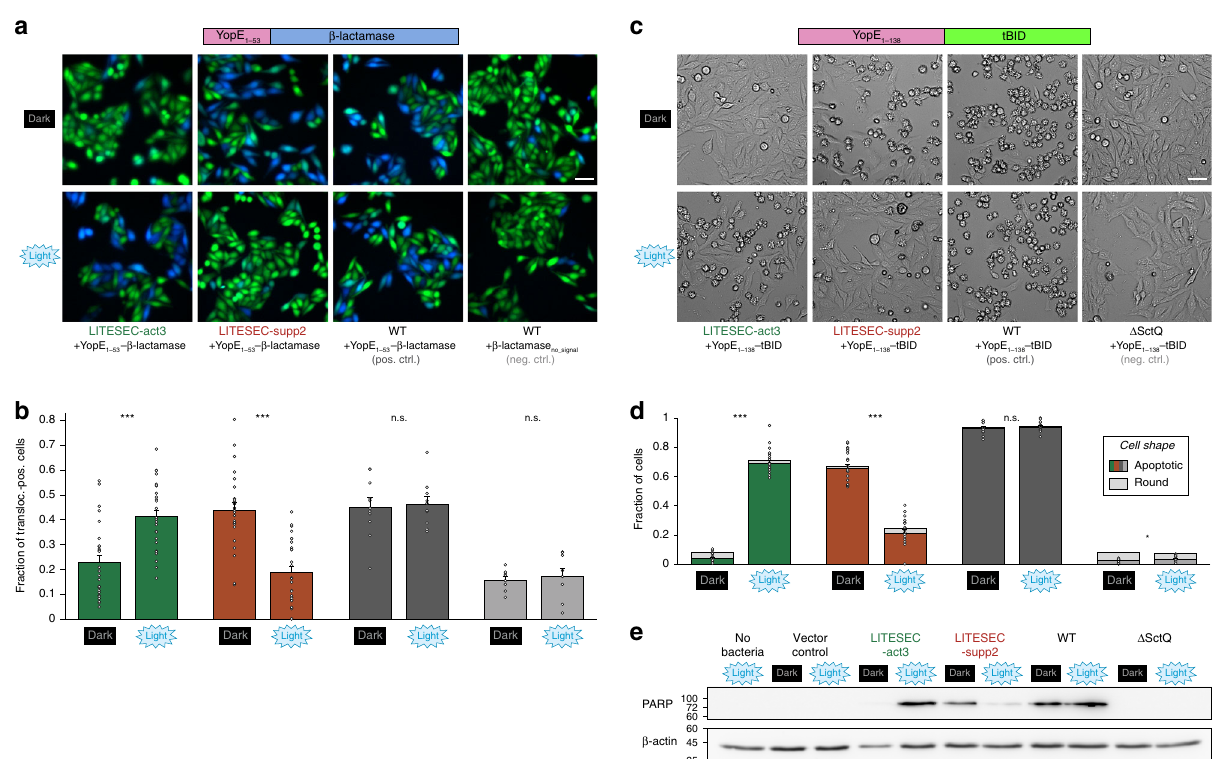
Fig. 8 Light-dependent translocation of heterologous cargo into eukaryotic host cells. a Fluorescence micrographs depicting cultured HEp-2 cells that were incubated with the indicated strains expressing either a heterologous T3SS substrate, YopE 1-53 - β -lactamase, or β -lactamase without a secretion signal as a negative control, for 60 min. Translocation of β -lactamase is detected by cleavage of the intracellular β -lactamase substrate CCF2 (leading to loss of FRET, and a transition from green to blue fl uorescence emission). Scale bar, 50 μ m. b Fraction of β -lactamase-positive HEp-2 cells in ( a ) (blue fl uorescence). 2343/2423/2226/2694 cells from 26/28/25/27 fi elds of view from three independent experiments were analyzed for the LITESEC strains under the given conditions from left to right (809/671/995/823 cells from 8/8/10/9 fi elds of view from three independent experiments for the controls). Single data points (percentage of positive cells per fi eld of view) indicated by circles; error bars display the standard error of the mean. *** p < 0.001 in a two-tailed homoscedastic t test; n.s., difference not statistically signi fi cant (exact values from left to right, 6 × 10 − 6 /2 × 10 − 8 /0.80/0.65). c Micrographs depicting cultured HEp-2 cells that have been incubated with the indicated strains expressing a heterologous T3SS substrate, YopE 1-138 -tBID 15 for 60 min. Translocation of tBID induces apoptosis, which leads to a condensed star-shaped host cell morphology. Scale bar, 50 μ m. d Visual classi fi cation of HEp-2 cells used in ( c ) after infection. 1522/1914/1510/1600/2299/1218/1468/1194 cells from 17/18/17/19/14/13/14/12 fi elds of view from fi ve independent experiments were analyzed per strain and condition (from left to right). Single data points (percentage of apoptotic cells per fi eld of view) indicated by circles; error bars display the standard error of the mean among fi elds of view. */*** p < 0.05/0.001 in a two-tailed homoscedastic t test; n.s., difference not statistically signi fi cant (exact values from left to right, 2 × 10 − 25 /1 × 10 − 15 /0.40/0.038). e Translocation of tBID induces cleavage of poly (ADP-ribose) polymerase (PARP), which was monitored by Western blot analysis of HEp-2 cells used in ( c ). β -actin was used as a loading control. Left, molecular weigth in kDa. Source data for panels ( b , d , e ) are provided as a Source Data